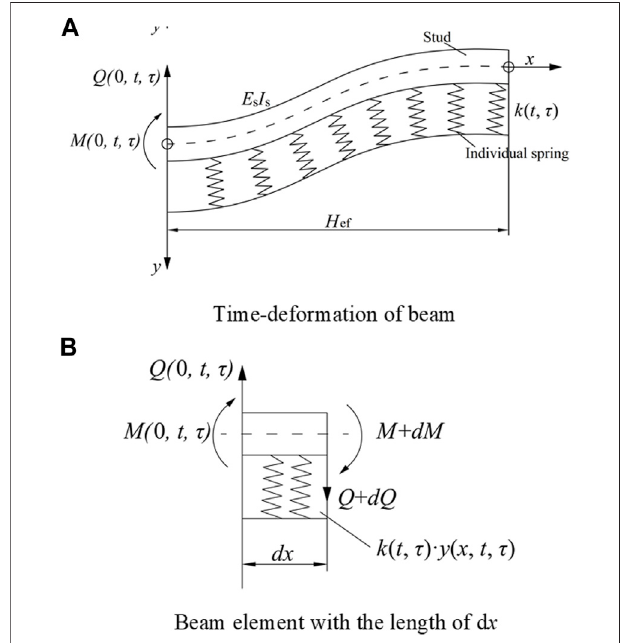
FIGURE 2 | Concepts of a beam on viscoelastic